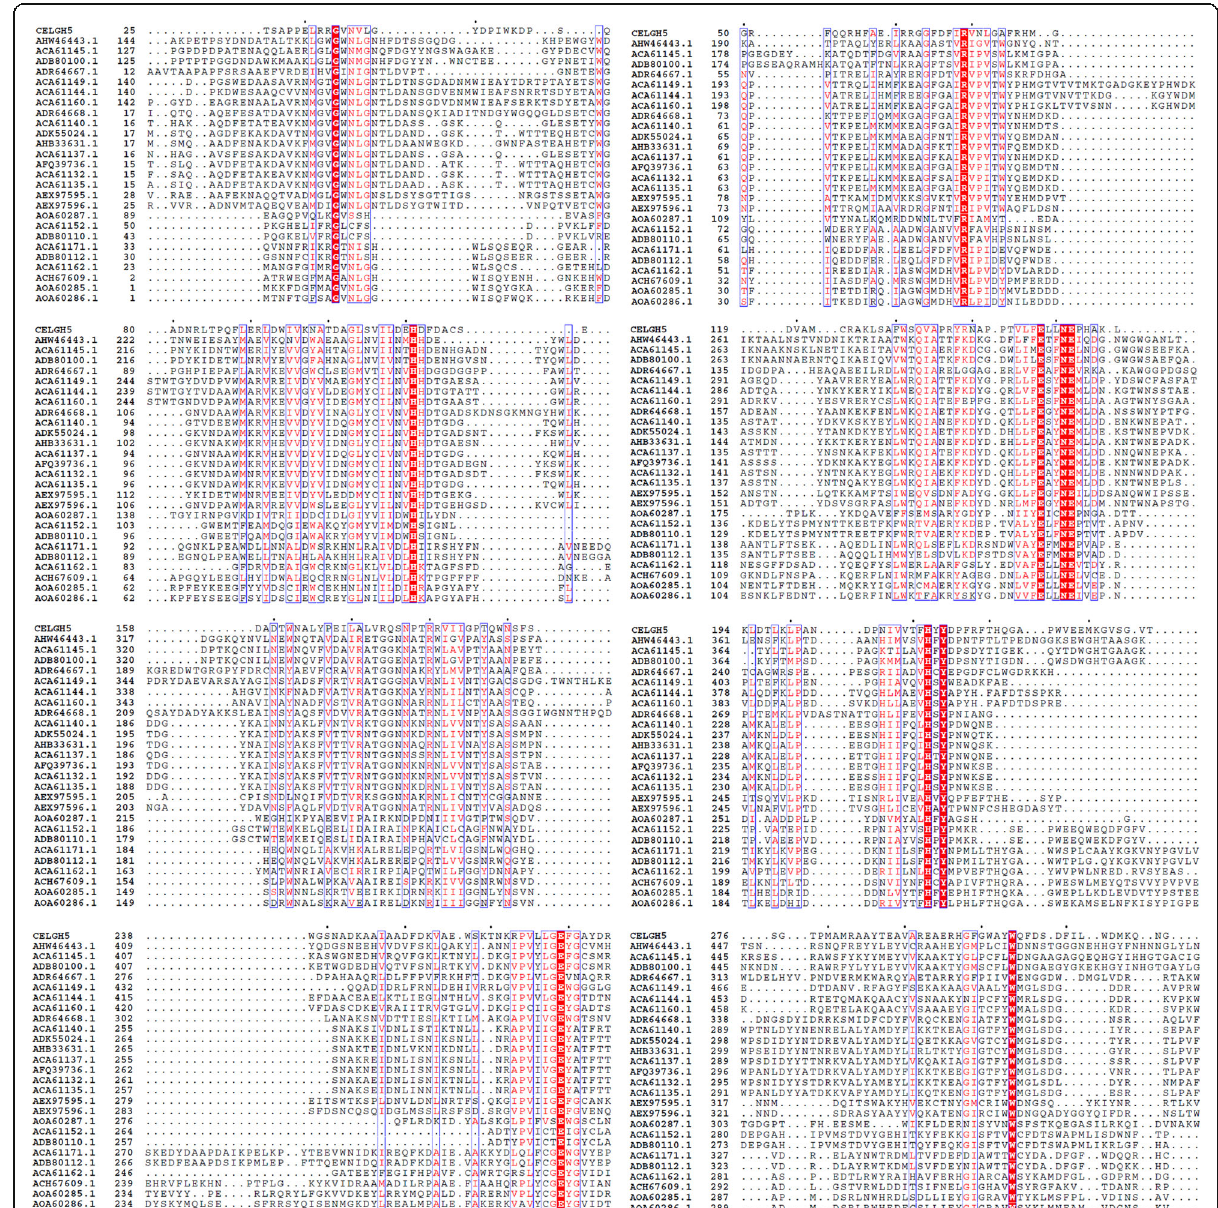
Fig. 8 Multiple sequence alignment of GH5-cellulase family from uncultured microorganisms. Conserved residues in the red